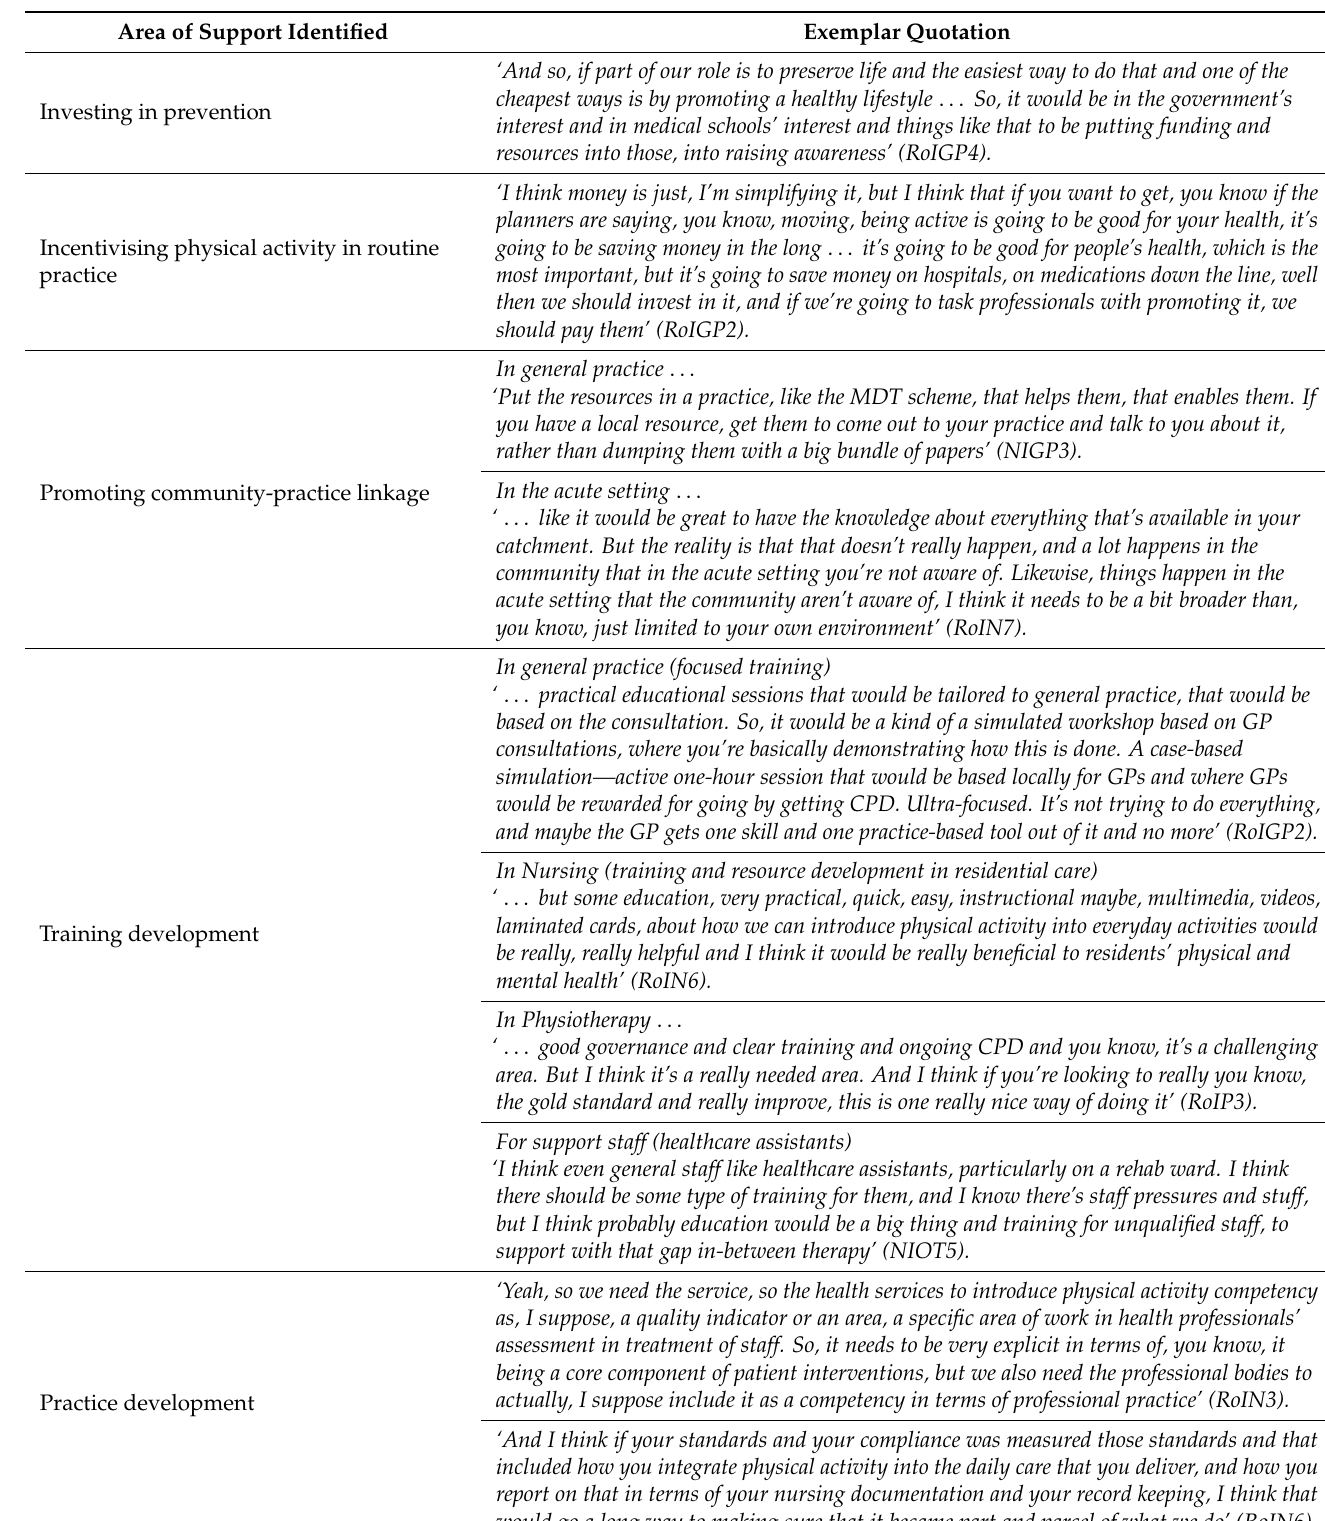
Table 3. Healthcare professionals’ quotations for emergent themes on developing practice to support the application and integration of physical activity